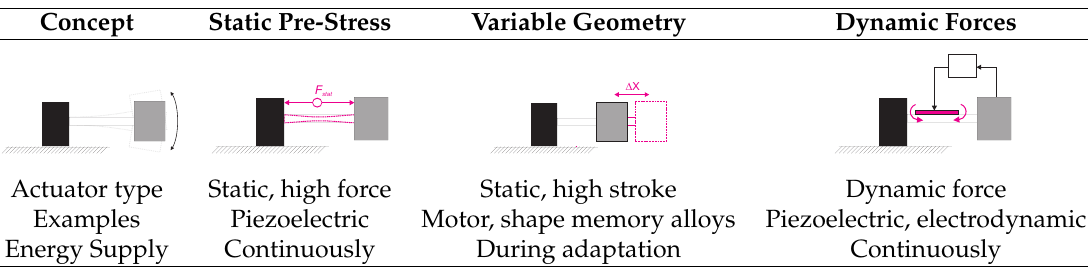
Table 1. Different adaptation concepts for neutralizers